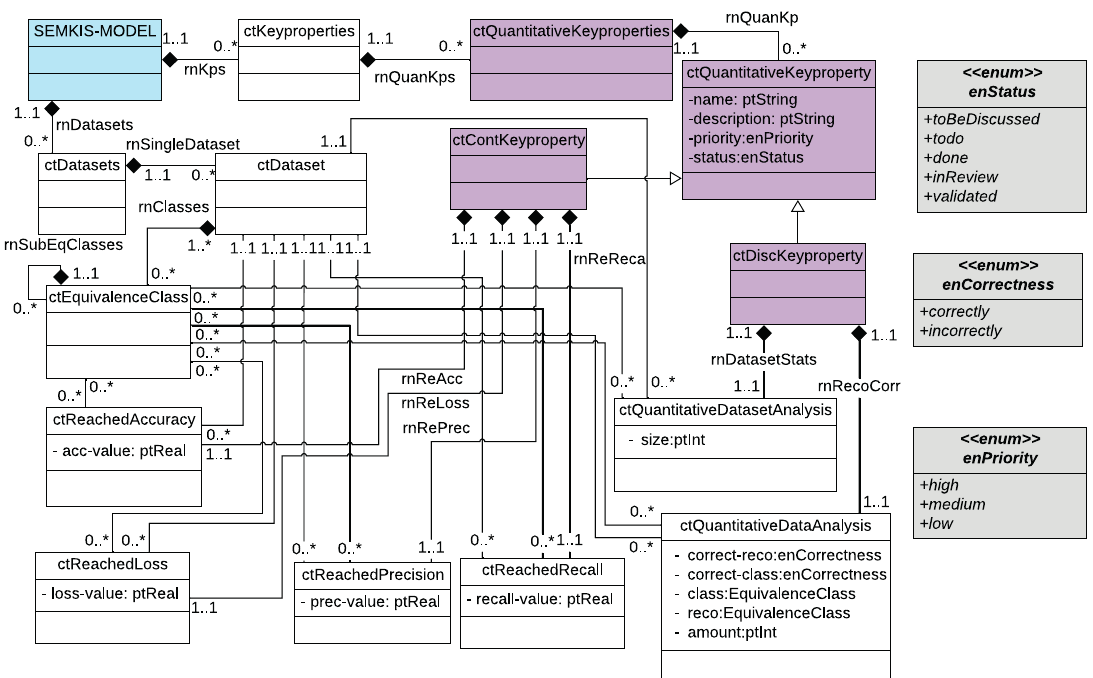
Figure 5. SEMKIS-DSL Metamodel: Quantitative key-properties specification